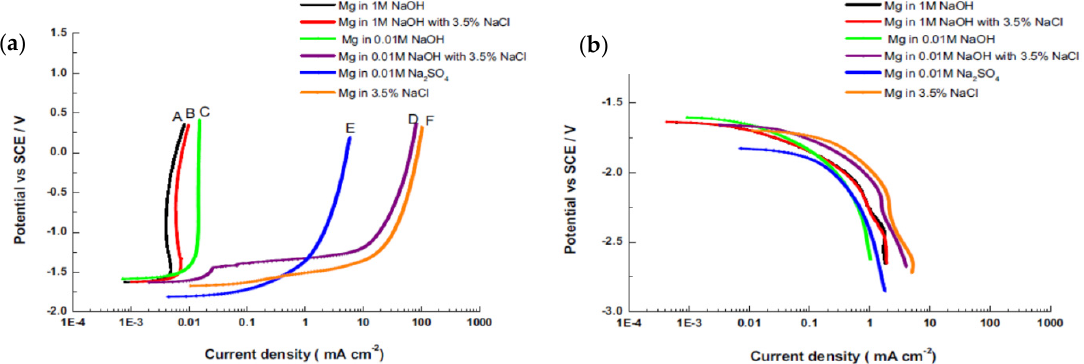
Figure 7. ( a ) Anodic polarization curves; ( b ) cathodic polarization curves [30].